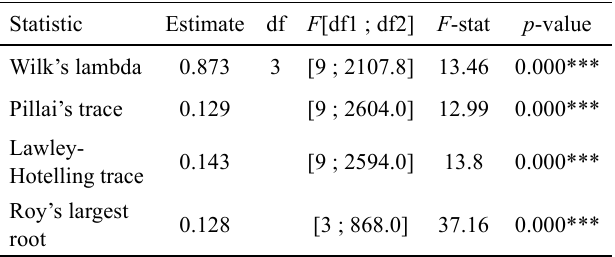
Fig 4 . Log-frequency of captured ants, Ectatomma ruidum , and other arthropods in repeated captures in pitfall traps. El Mira Research Center, Tumaco, Pacific Coast of Colombia, 2017. Table 1 . Statistics of MANOVA for observed captures of non-ant arthropods, ants, and Ectatomma ruidum across